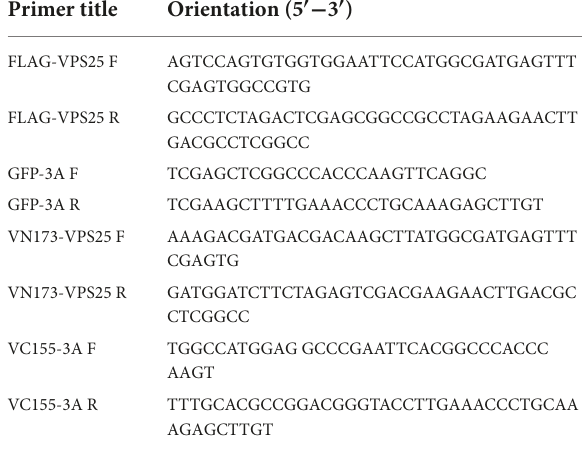
TABLE 1 List of primers used in this